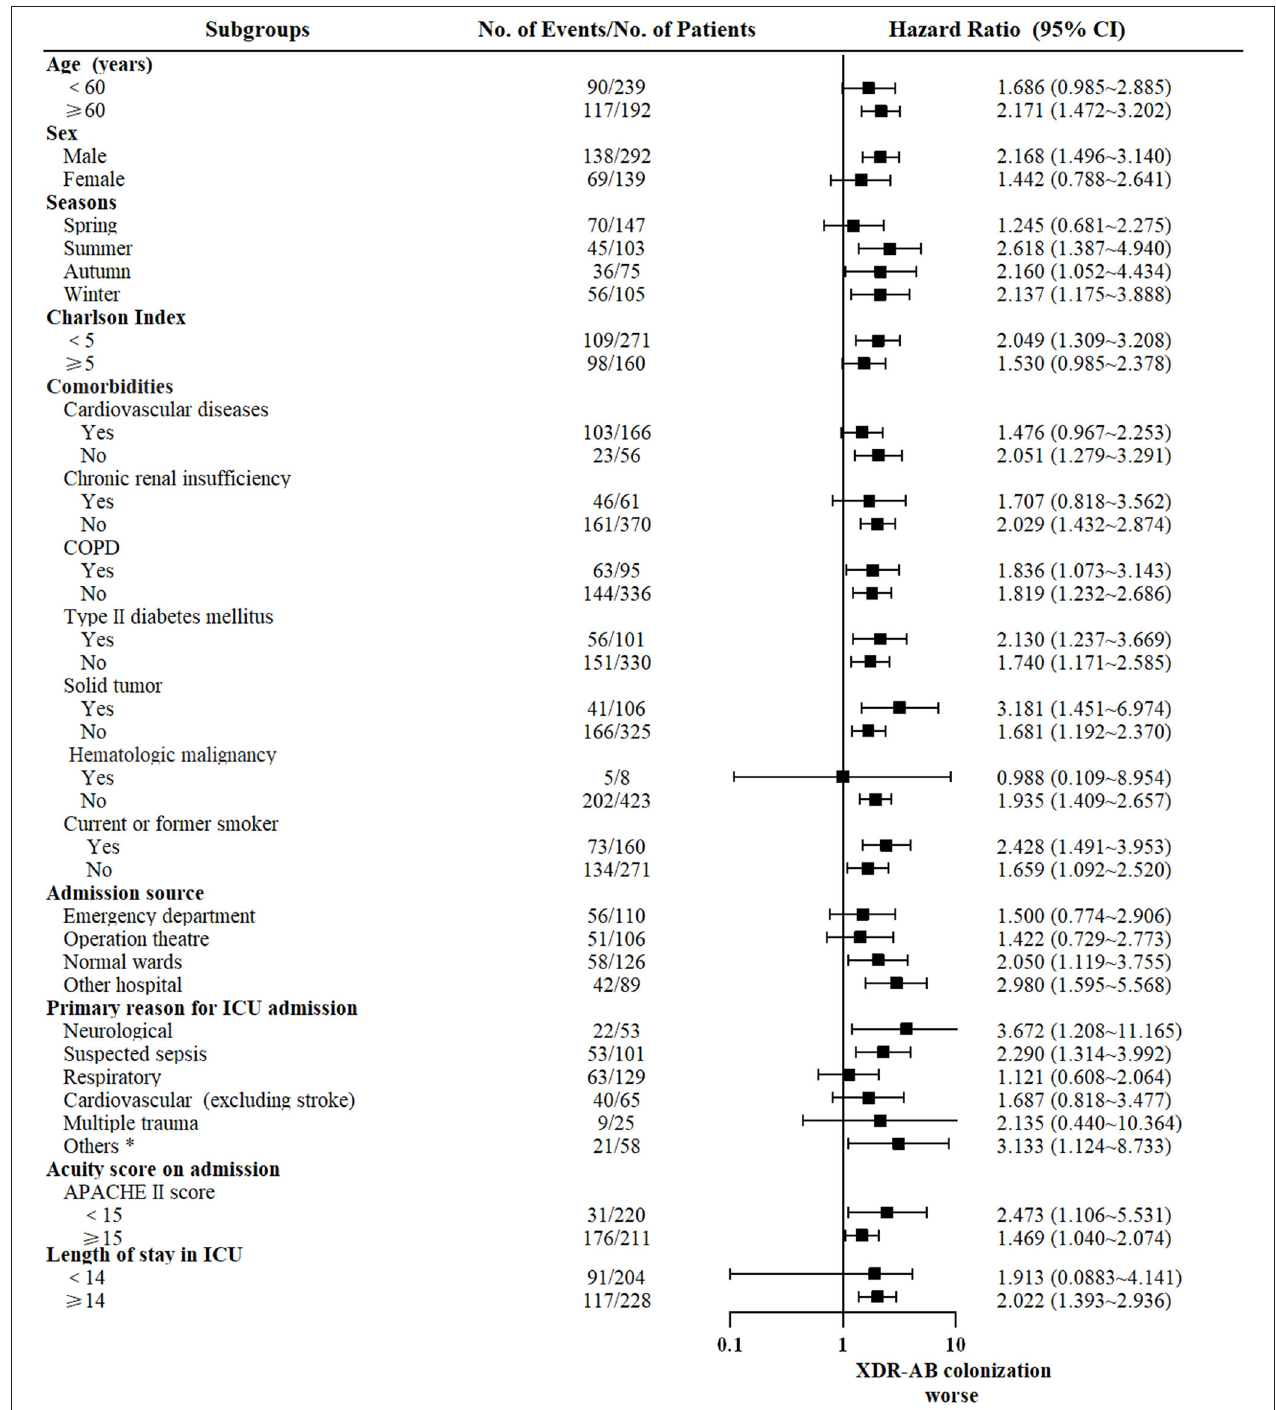
FIGURE 2 | Subgroups analyses of the impact of XDR-AB colonization on mortality at 6 months. Shown are hazard ratios for 6-month survival with XDR-AB colonization compared with no colonization. *Included burns and hepatobiliary, pancreatic, gastrointestinal, and genitourinary diseases.